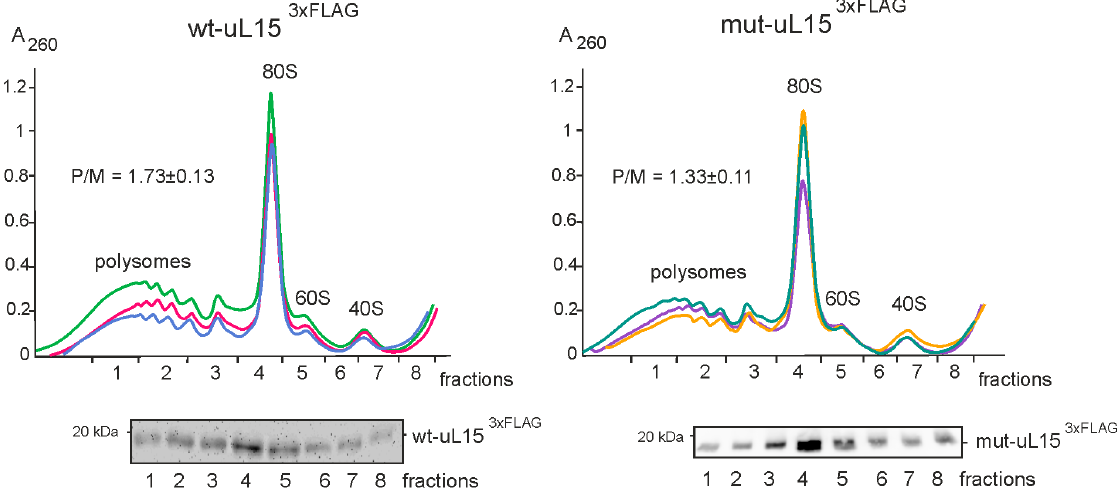
Figure 2. Polysome profiles obtained from the lysates of HEK293T cells, producing wt-uL15 3 × FLAG (top left) and mut-uL15 3 × FLAG (top right). Profiles from three biological replicates are presented in different colors and superimposed. Peaks corresponding to polysomes, 80S monosomes, and 60S and 40S ribosomal subunits are designated. The mean ratio of the polysome peaks to the monosome peak (P/M) with the SD, determined from biological replicates, is shown on each panel. Western blot analyses of the content of FLAG-labeled exogenous proteins in the gradient fractions are shown below the polysome